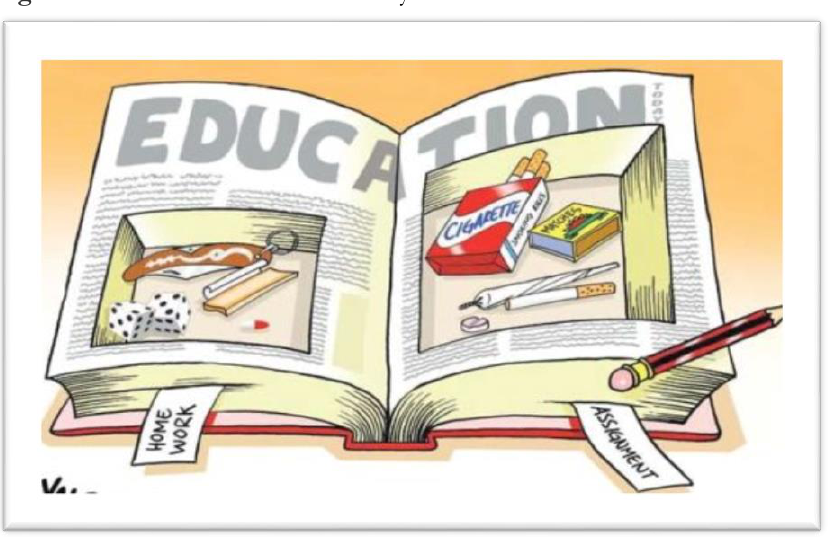
Yalo | Mar 25, 2011 | Sowetan